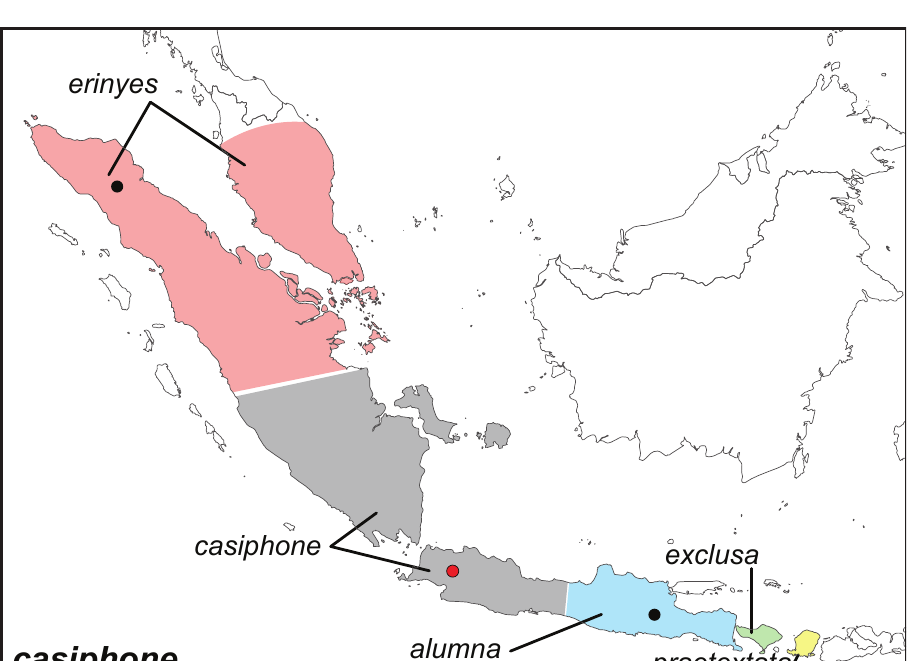
Figure 51. Distribution map of Elymnias nesaea .